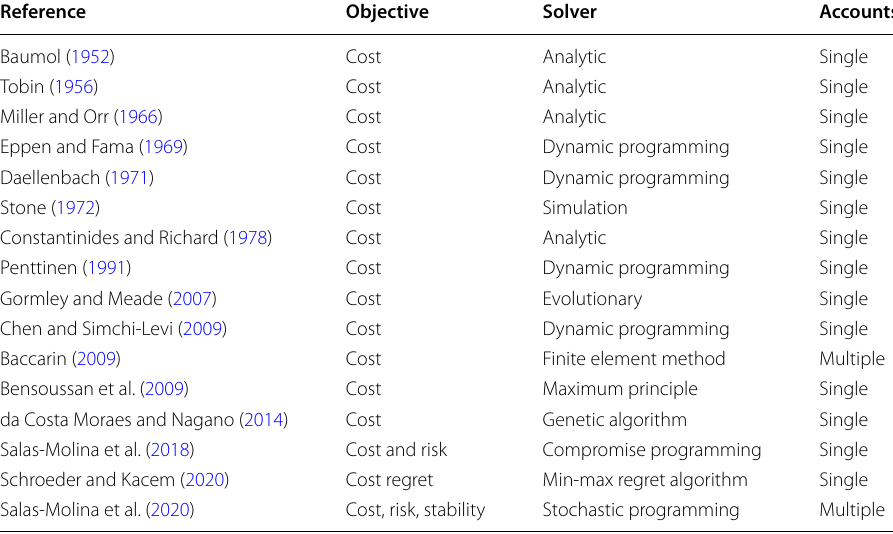
Table 2 Characteristics of CMP models